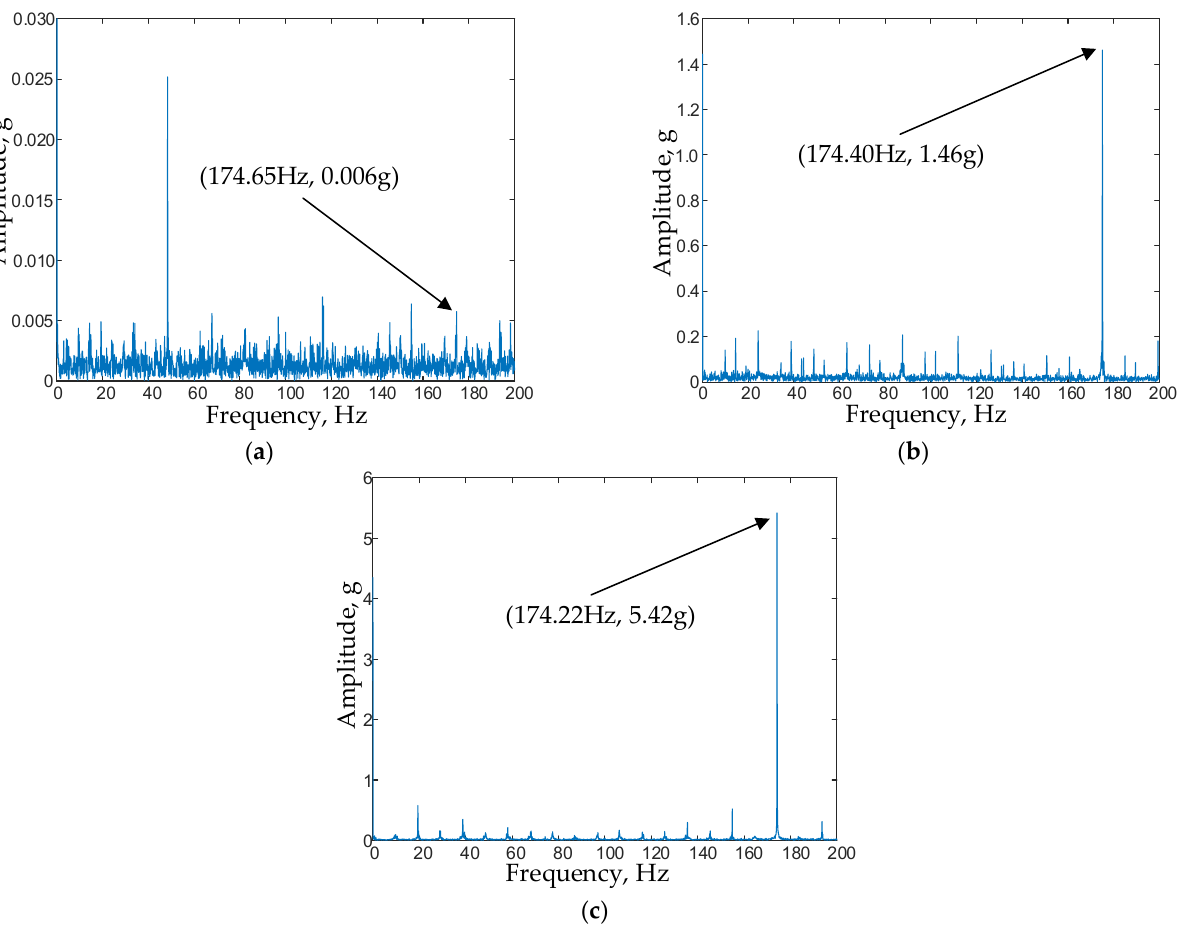
Figure 4. Resonant demodulated spectra of the vibration acceleration signal of the Y100L-2 motor with a full load: ( a ) healthy; ( b ) slight outer race fault; ( c ) severe outer race fault. Table 4. Bearing outer race fault diagnosis results of the Y100L-2 motor with a full load.